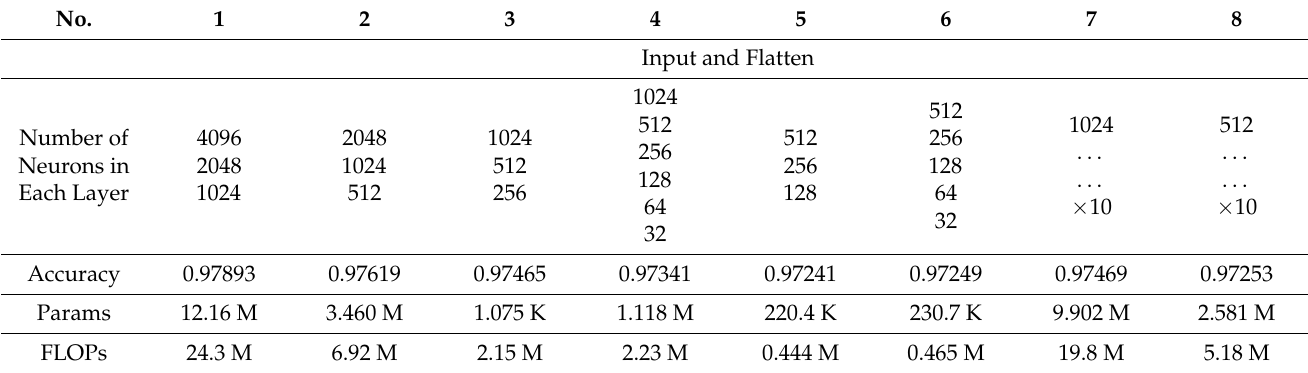
Table 3. Overview of fully connected models.